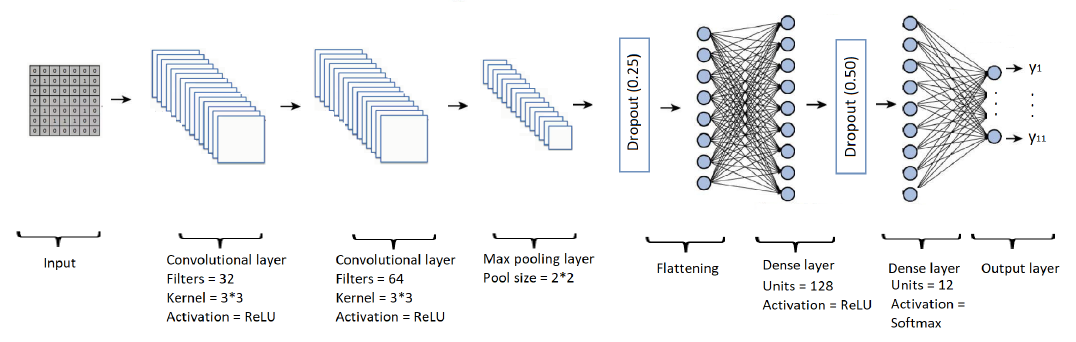
Figure 2. Architecture and parameters of the convolutional neural network (CNN) architecture